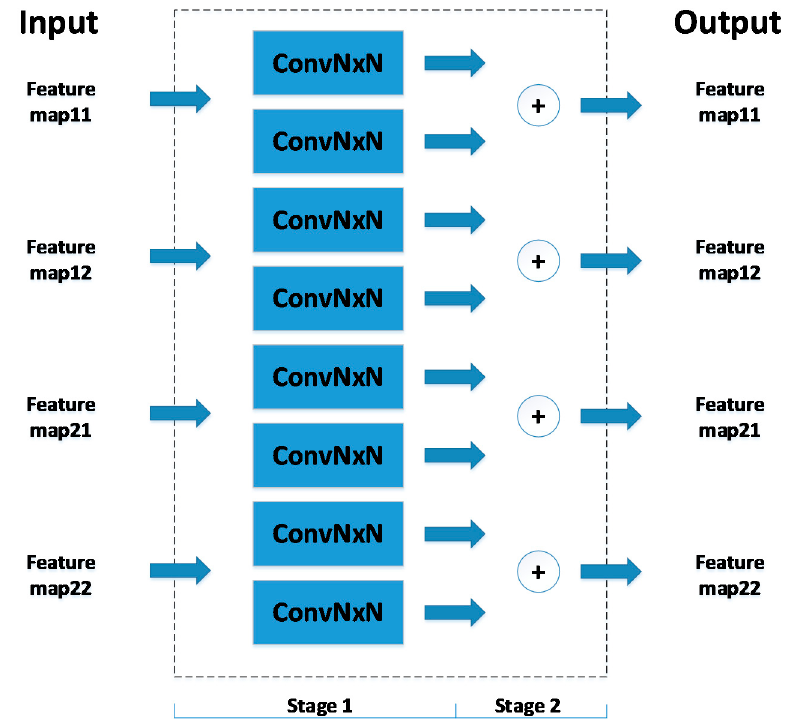
Figure 2. Schematic representation of the architecture for the conventional design.